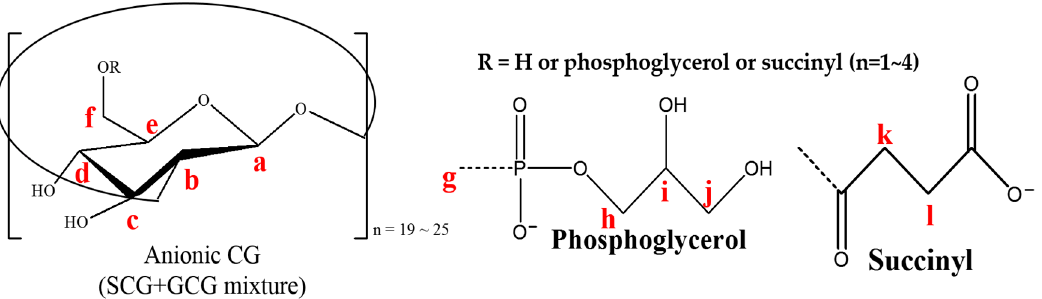
Figure 2. Structures of the anionic CG from Sinorhizobium meliloti 1021. Each of the two substituents, phosphoglycerol and succinyl, was attached to CG separately as SCG or GCG. No anionic CG containing both substituents was found.